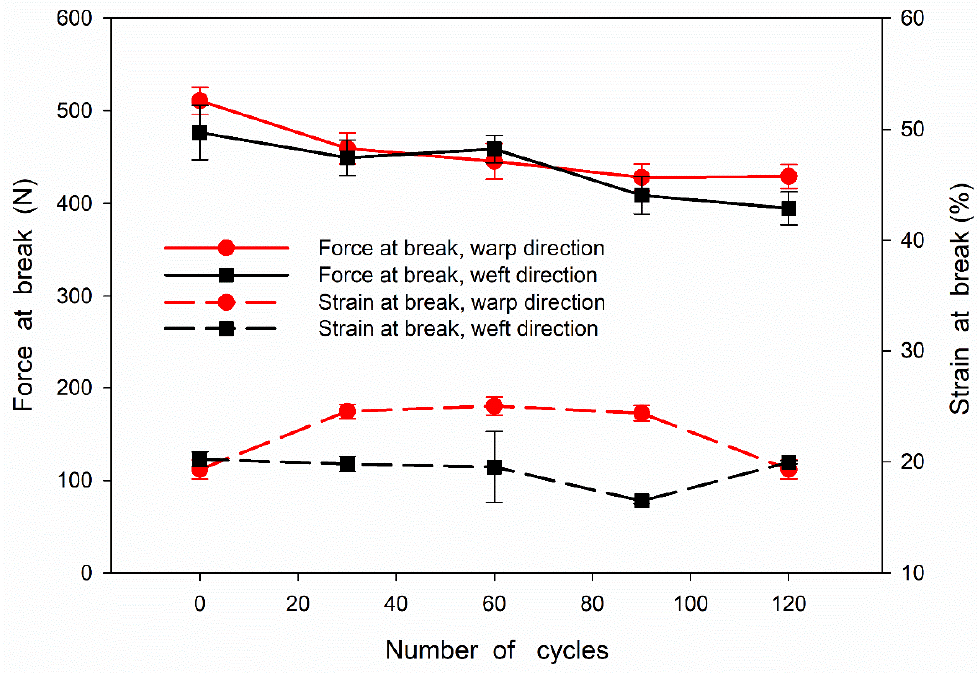
Figure 3. Dependencies of force and strain at break on number of disinfection and washing cycles of cotton fabric.